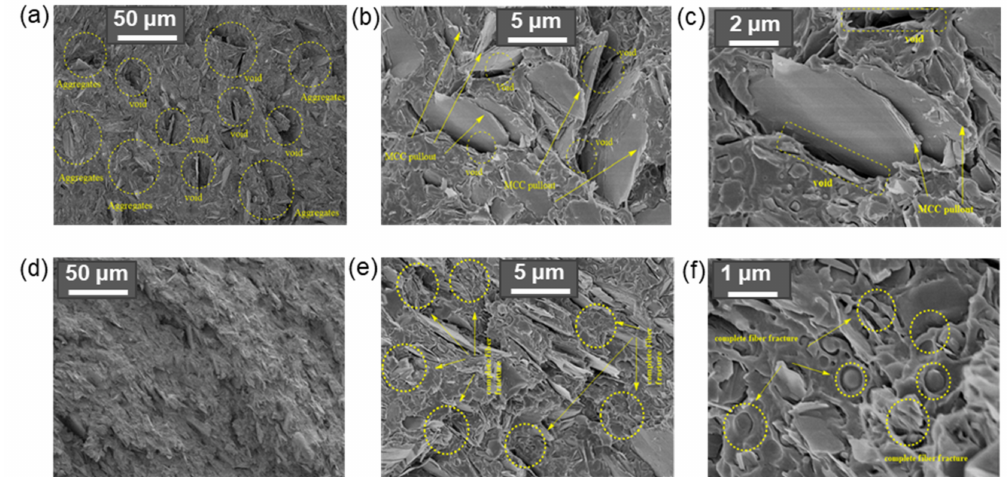
Figure 16. Distribution of neat and modified CMC (3 wt%) in the PLA matrix (SEM): ( a ) sur- face of PLA/CMC; ( b , c ) fractured surface of PLA/CMC at different magnifications; ( d ) surface of PLA/modified CMC; ( e , f ) fractured surface of PLA/modified CMC at different magnifications. The CMC modification with toluene-2,4-diisocyanate was carried out for 24 h to reach the maximum functionalization. Reproduced from [32] with permission of American Chemical